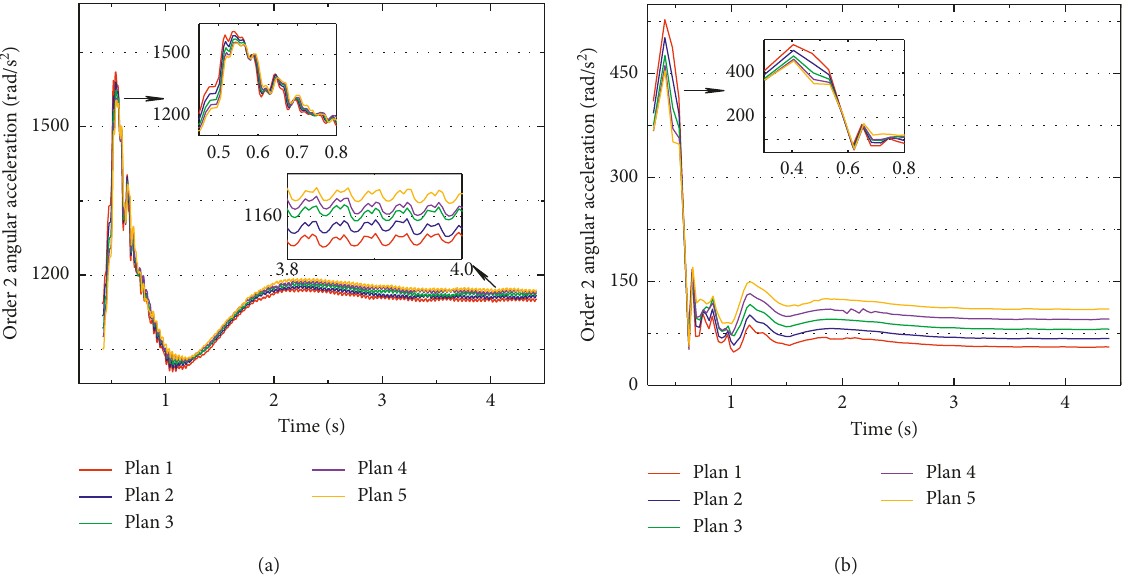
Figure 14: The 2 nd order angular acceleration under different damping schemes in Phases B and C. (a) The primary side result; (b) the secondary side result.